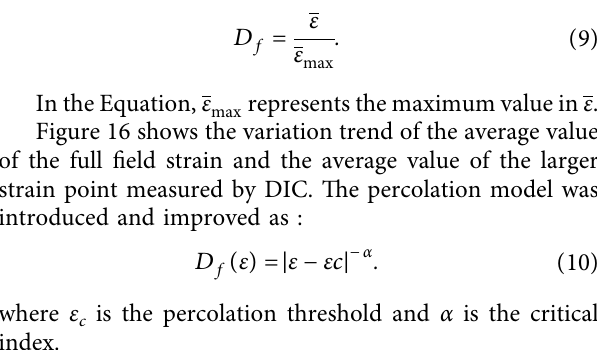
Figure 16: Variation trend of strain value measured by